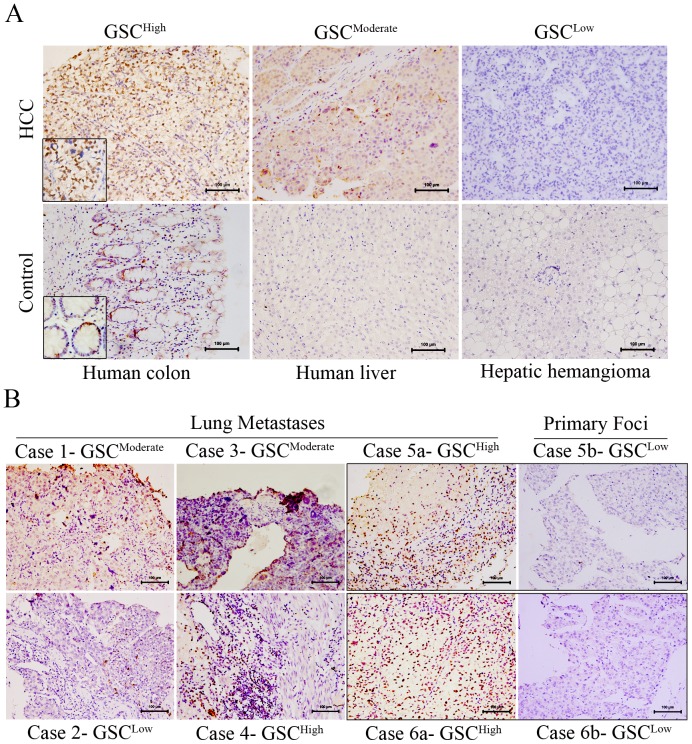
GSC expression in HCC tumor tissues.Immunohistochemistry analysis was performed based on tissue microarray. (A) Top-row shows the staining of GSC from strong to low. Bottom-row shows the controls to confirm the specificity of the GSC antibody. Colon tissue staining was used as the positive control. (B) Six tumor tissues in lung metastases from HCC showed the highly expressed GSC. Comparison of two paired tissues (case 5 and case 6) from lung metastatic cancer and primary foci showed the upregulated GSC expression in lung tissues. (200× original magnification, size bar: 100 µm).